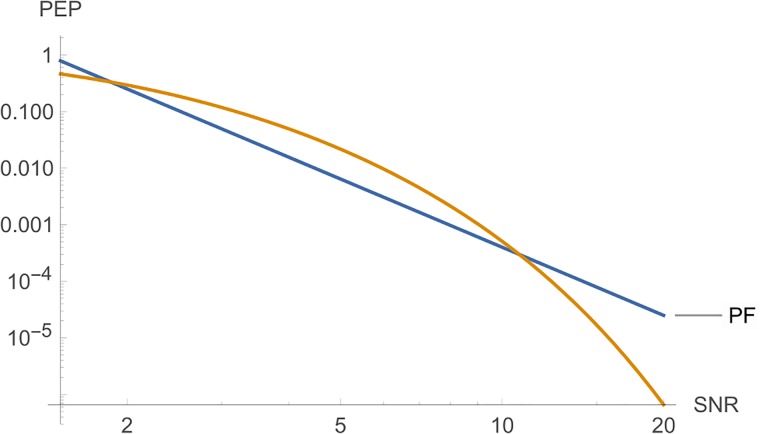
Graphs of PE and PF for Example 7, where nT = nR = l = 2, and SNR is a function of Es.